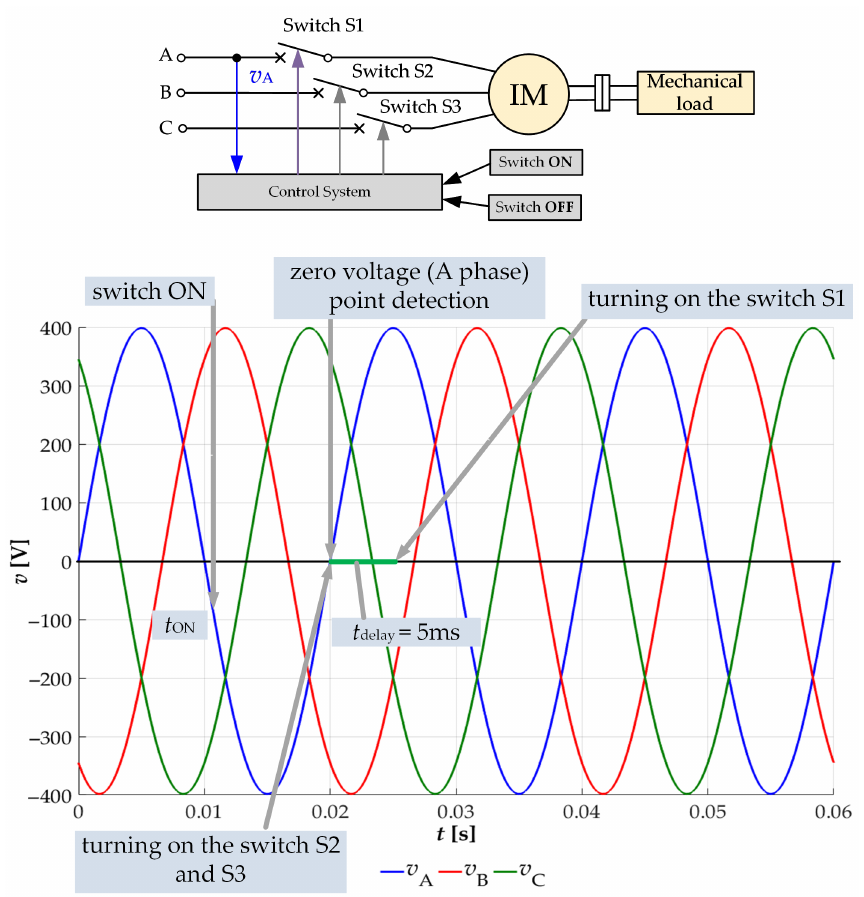
Figure 3. The idea of limiting the oscillation of the electromagnetic torque during the starting of the drive system with an induction